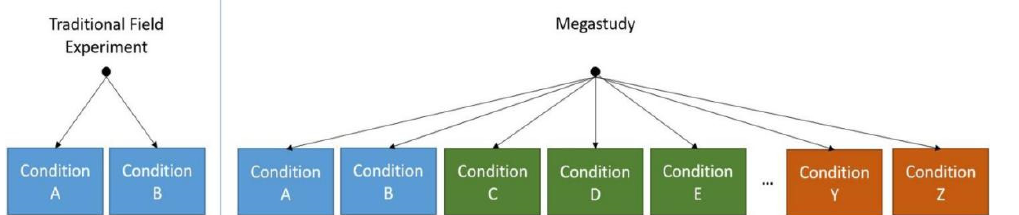
Figure 1. By Duckworth and Milkman, in A Guide to Megastudies . Left panel: traditional field experiments randomly assign participants to multiple conditions (e.g., conditions A and B), testing a limited number of related hypotheses. Right panel: megastudies randomly assign participants to a larger set of treatments often clustered by sub-study (different colors indicate different sub-studies), each testing potentially unrelated hypotheses (e.g., conditions A, B, C, D, etc.) [44].